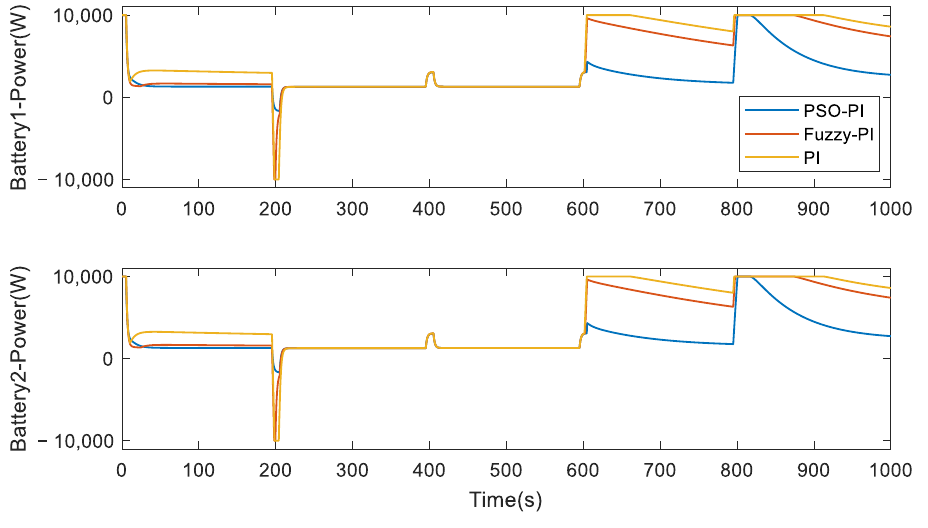
Figure 17. Output power of battery in Example 1.